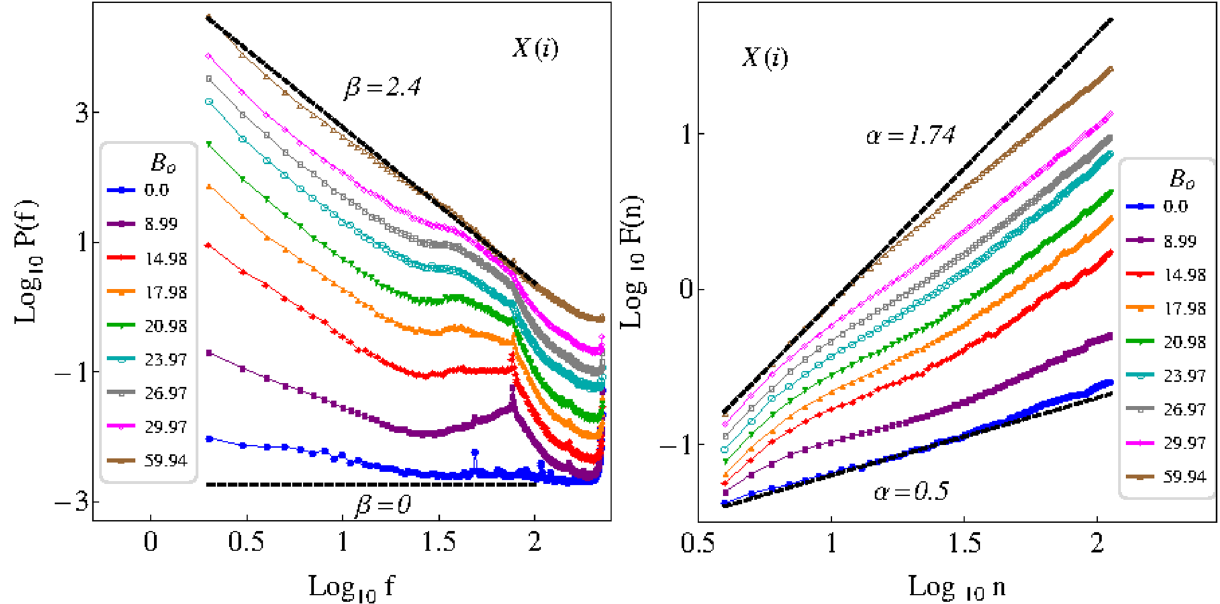
Figure 5. Fourier power spectra of the time series of the particle positions, in the x -direction, X ( i ) (left panel), and the corresponding results of applying the DFA method to the same time series (right panel), when a constant magnetic field, B c = 36 G, is introduced. The values of B o and φ s considered are the same as in Figs. 2 and 3. Unlike when B c = 0 , the power law behavior breaks down. The results correspond to averages over all the